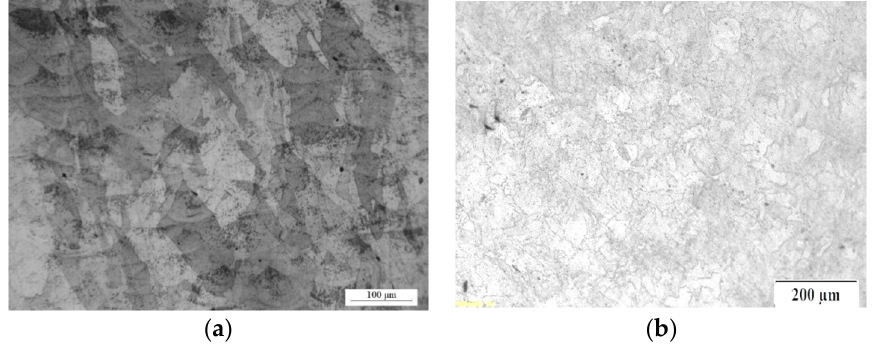
Figure 6. X-ray diffraction pattern of a nitrided layer on a 12X18H10T steel specimen manufactured by the LB-PBF.